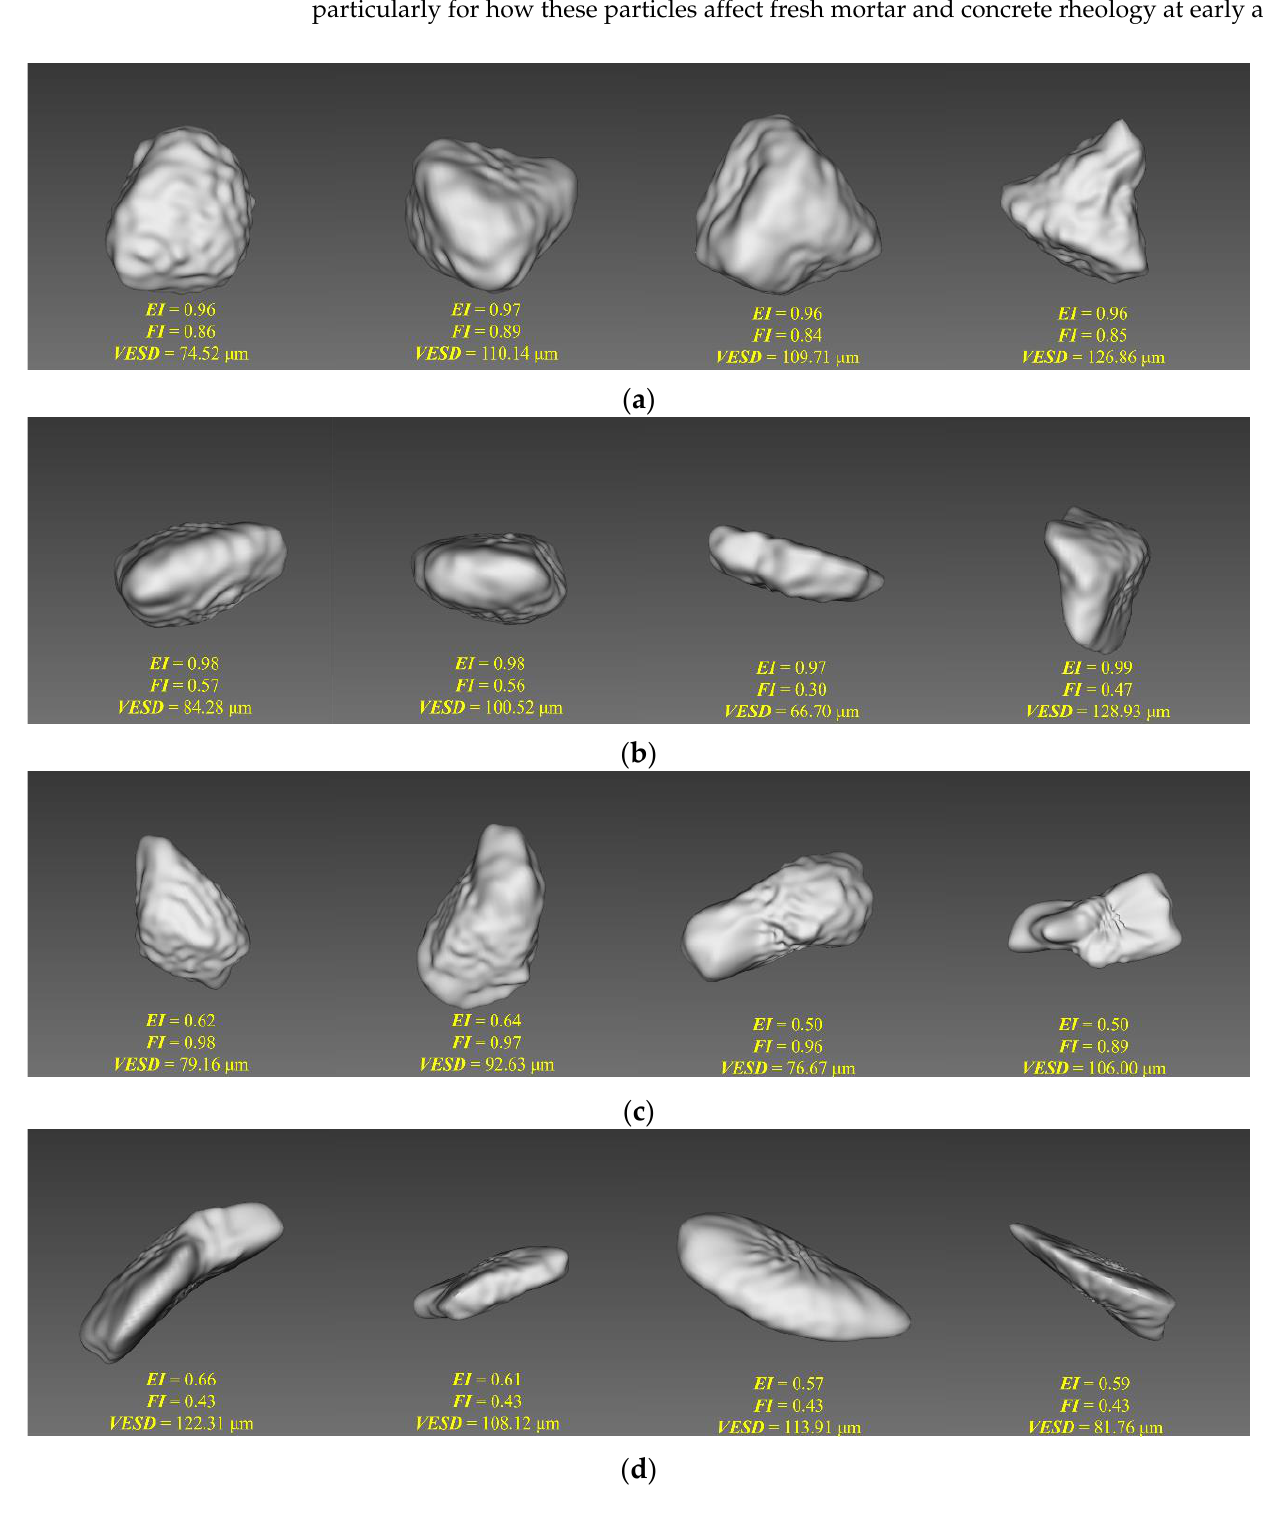
Figure 13. Three-dimensional view of reconstructed desert sand particles classified in different categories: ( a ) spheroid; ( b ) oblate; ( c ) prolate; ( d ) blade.